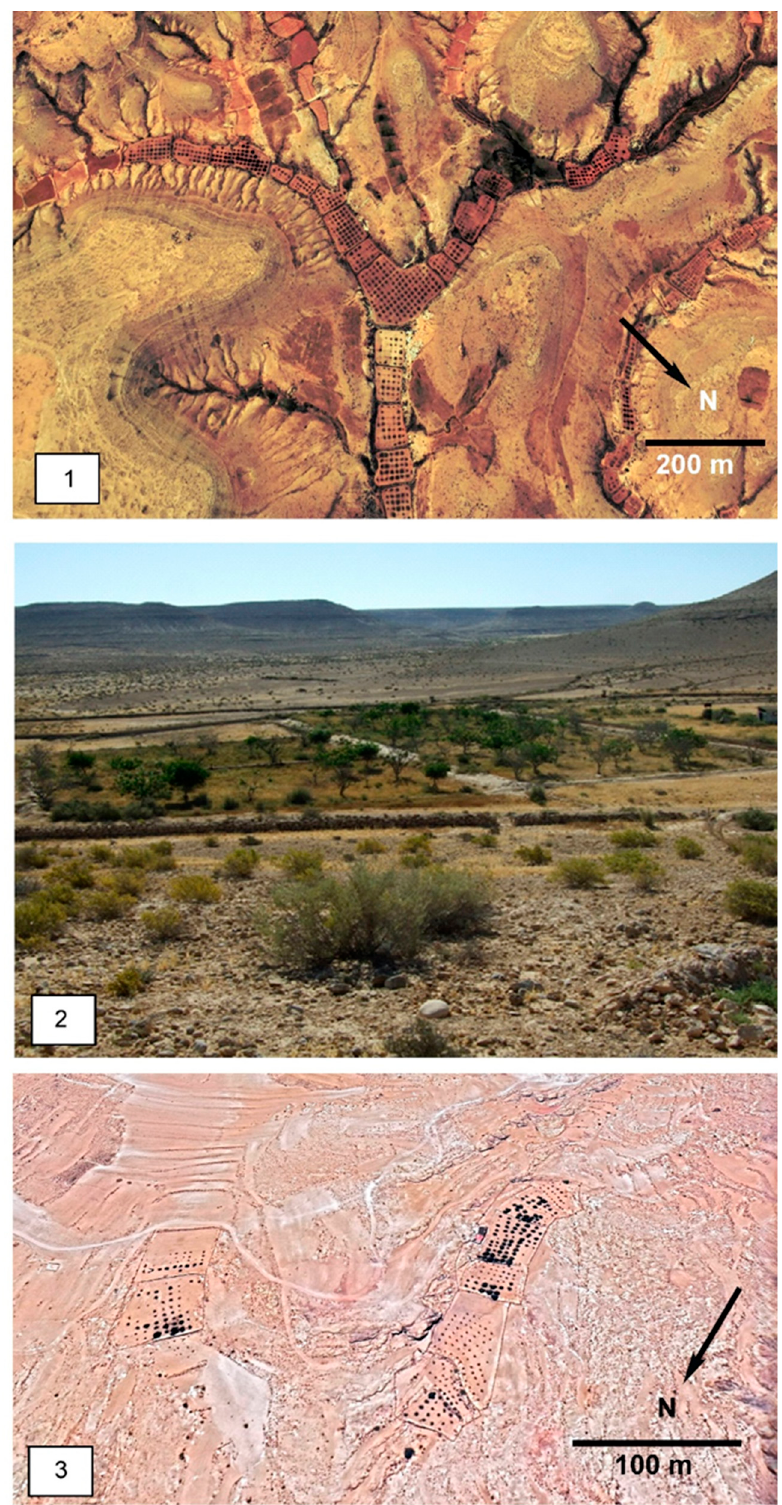
Figure 2. General view of the study regions emphasizing past and present desert agriculture and terrace farming. 1. Marmarica region, 15 km south-west of Marsa Matrouh. 2. Southern Negev Highlands. 3. Petra region, 3 km north-west of the Petra site. 1 and 3 are Google Earth imagery, while 2 is a photograph by Y. Avni.